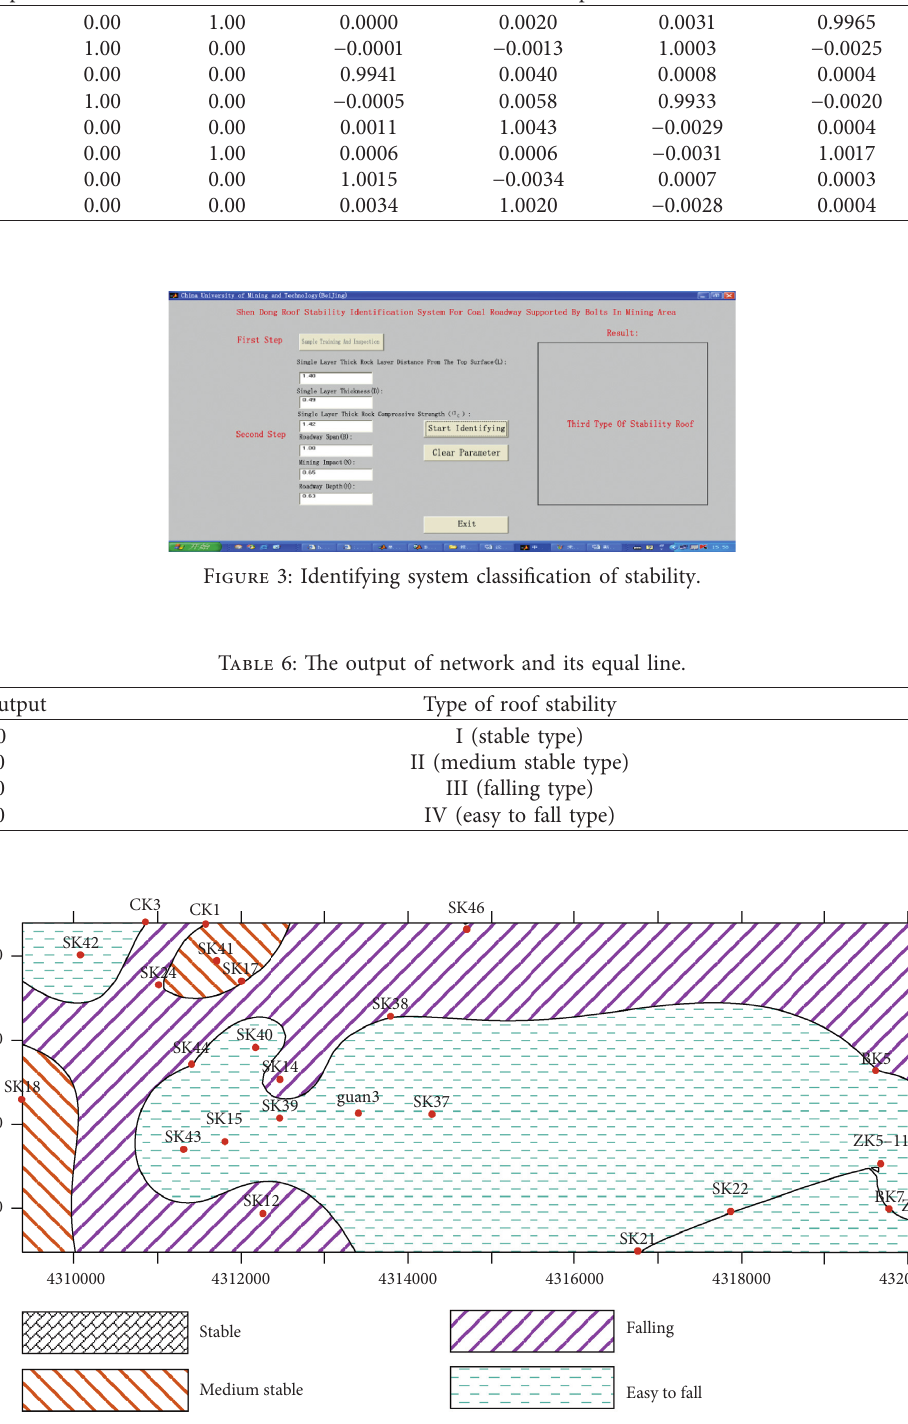
Figure 4: The stability equal line fig of number 8 coal seam roadway roof of